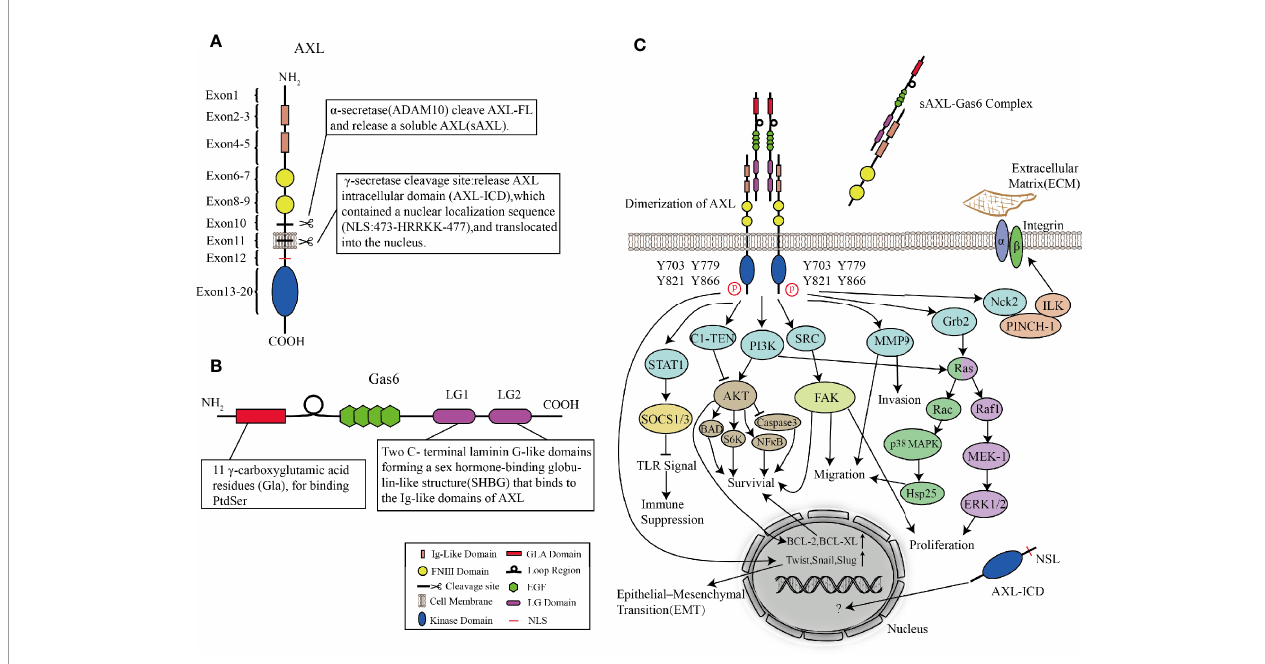
FIGURE 3 | Structures of AXL and Gas6, and AXL signaling pathways. (A, B) Molecular structures of AXL (A) and Gas6 (B) . (C) AXL binds to the ligand Gas6, and then the tyrosine kinase domain is activated, mediating cascade reactions such as cell survival, proliferation, migration, invasion, immune suppression, and cytoskeleton